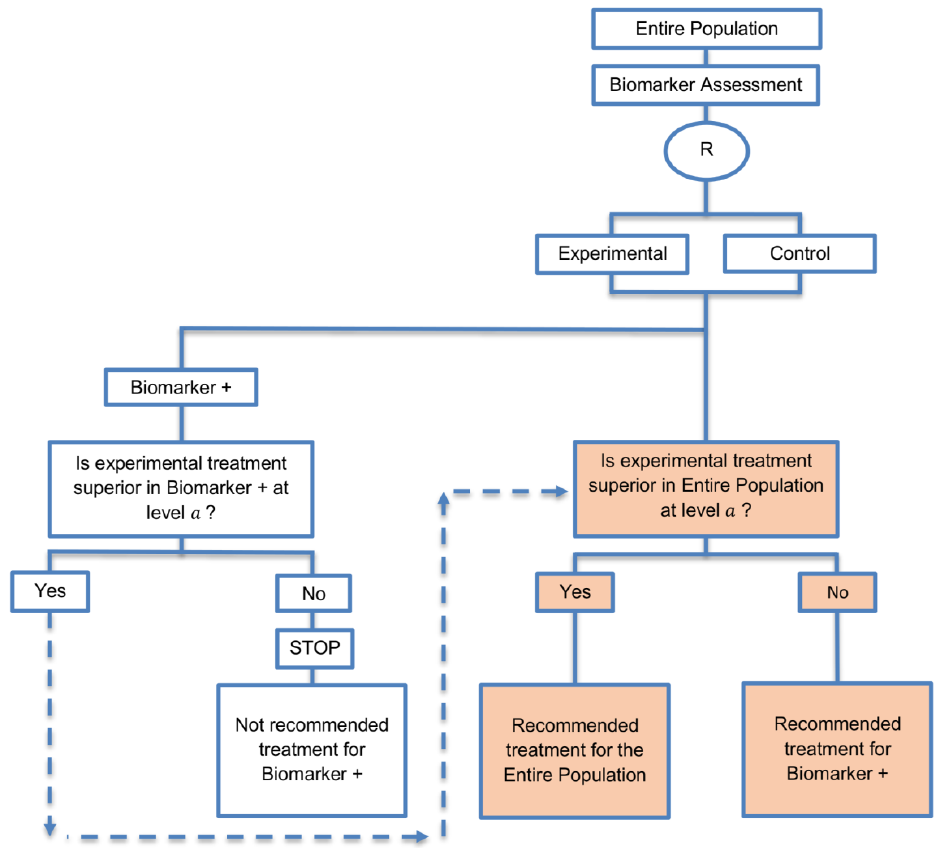
Figure 8. Biomarker-positive and overall strategies with sequential assessment. “R” refers to randomization of patients. Uncolored boxes are referred to the first stage of the trial and colored boxes are referred to the second stage of the trial.